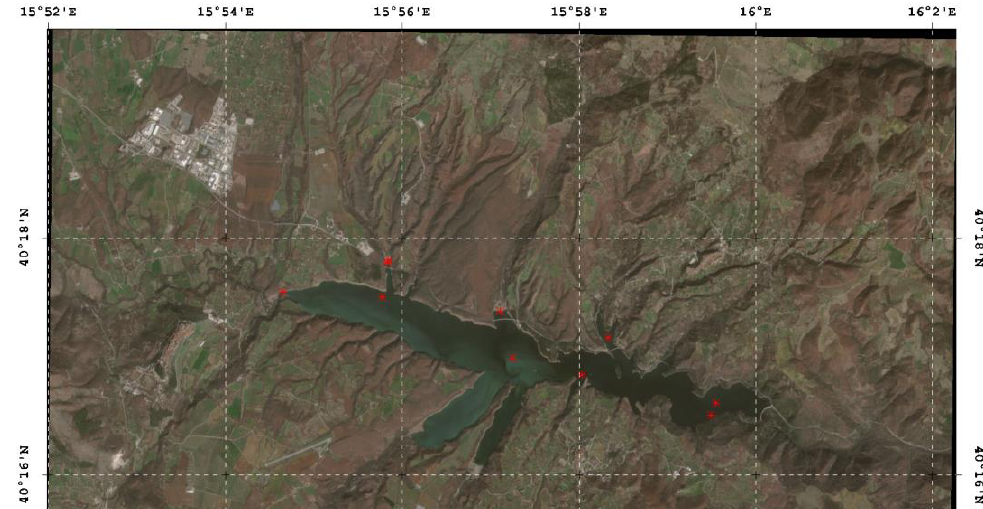
Figure 3. Atmospherically corrected S-2A true-color image of Lake Pertusillo, 27 February 2017, showing prominent black and blue-greenish patterns, as reported from terrestrial and drone observations (Figure 4). Red asterisks show the ground data collection sites listed in Table 1.